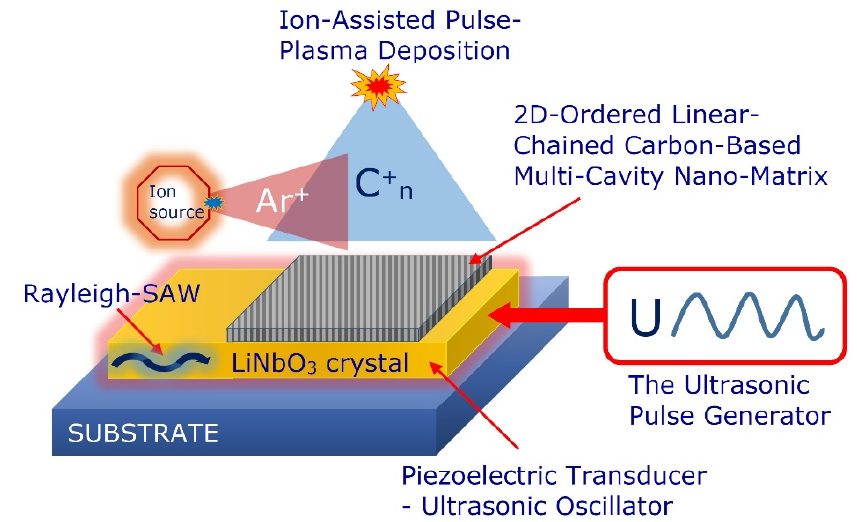
Figure 8. Schematic representation of using inverse piezoelectric effect during the nanomatrix ion-stimulated pulse-plasma deposition and schematic illustration of SAW streaming.